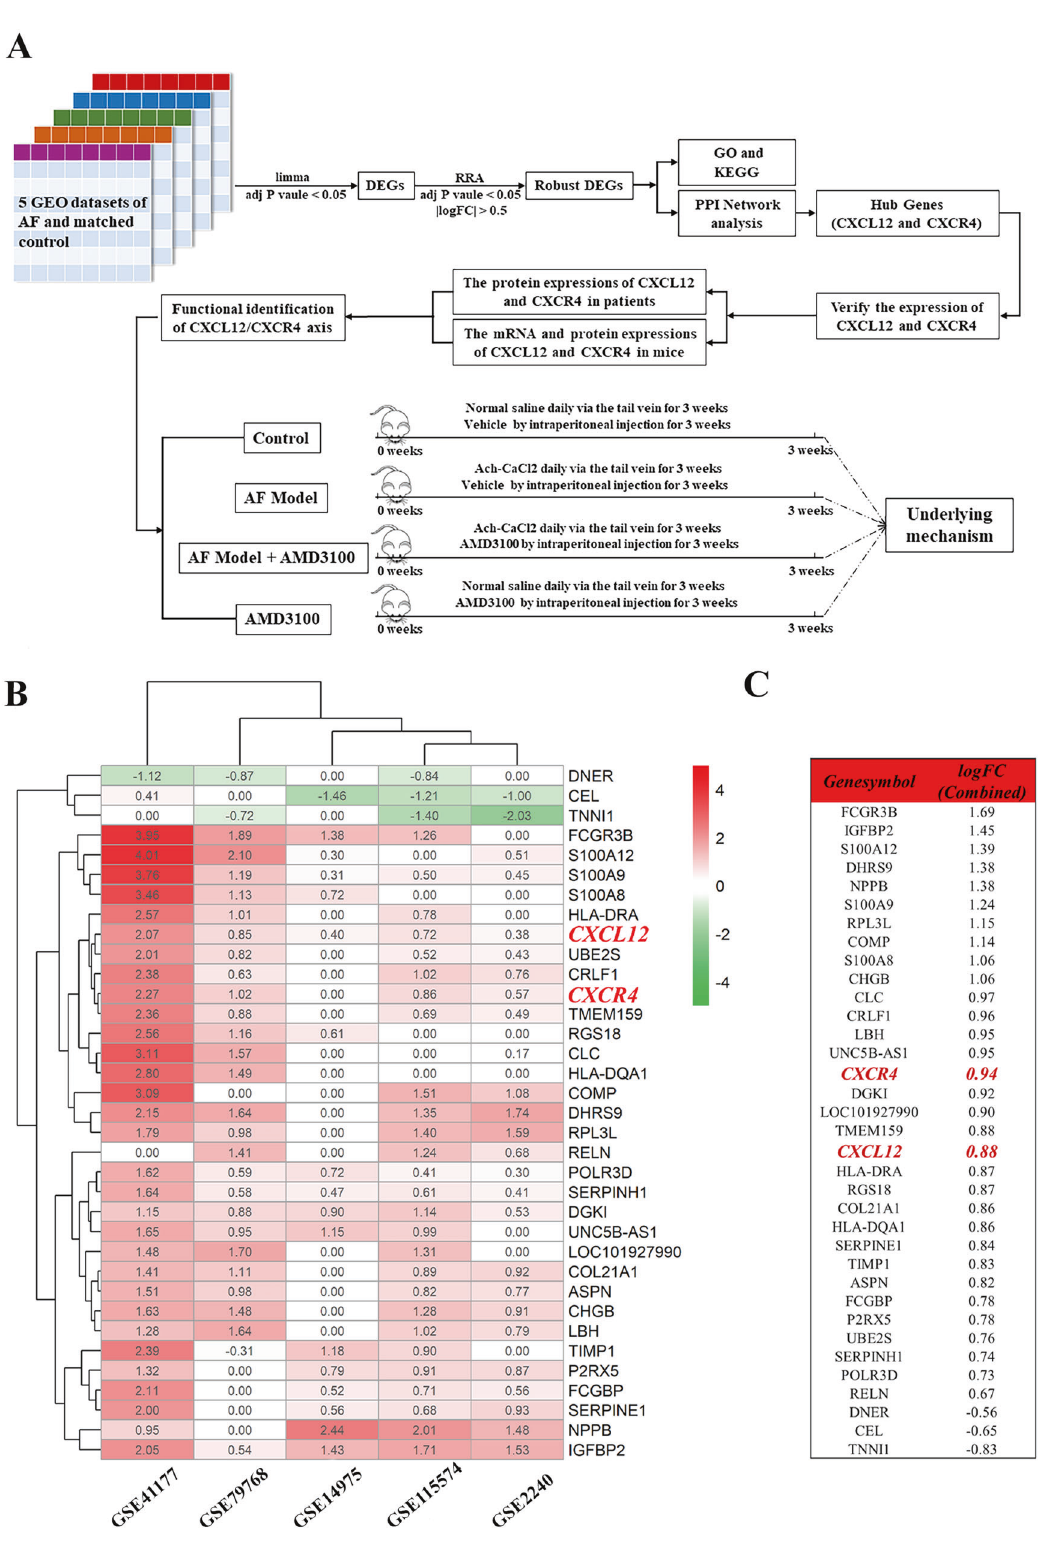
Fig. 1 The research route and DEGs between AF and matched control by RRA analysis. A The research route and framework. B Heatmap shows the 35 DEGs between the AF group and matched control. There are 32 upregulated genes and three downregulated genes in AF group compared with the control group. Each row represents one gene and each column indicates one dataset. The red rectangles indicate the genes are upregulated in AF group, on the contrary, the green rectangles indicate the genes are downregulated in AF group. The number in the rectangle is the log2 FC of the gene (compare to the control group) in 5 respective datasets. C The combined log2 FC of 35 DEGs calculated by RRA based on 5 datasets. The combined log2 FC of CXCR4 and CXCL12 are 0.94 and 0.88, respectively, which means these two genes are signi fi cantly upregulated in AF group. DEG differentially expressed gene, GEO gene expression omnibus, RRA robust rank aggregation, GSE gene expression omnibus series, log2 FC log2 fold